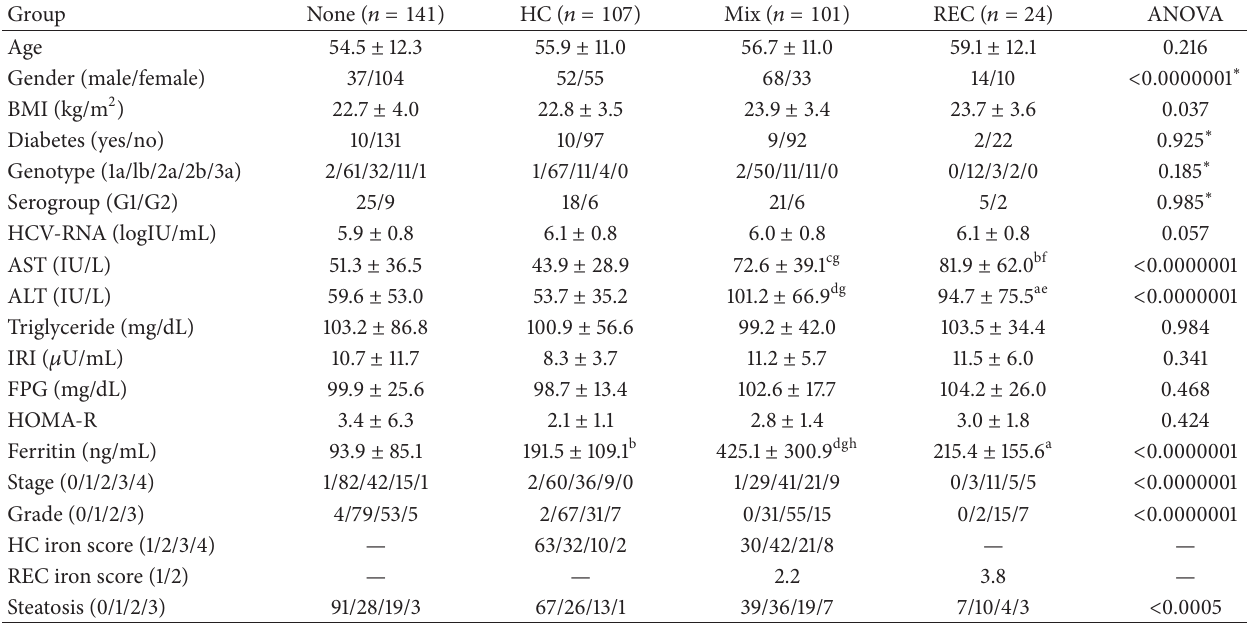
Table 1: Clinical characteristics of patients.